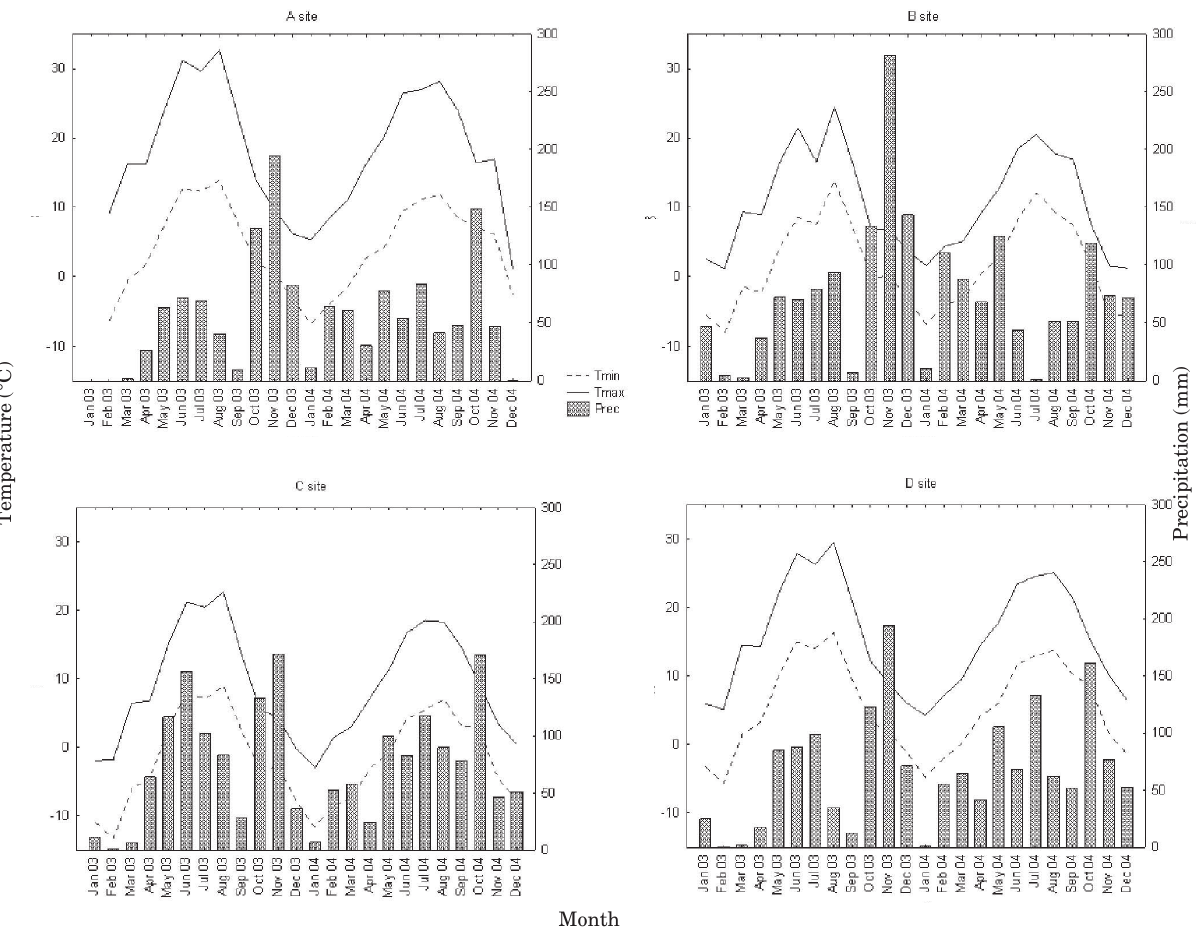
Fig. 1. Minimum and maximum temperature (Tmin, Tmax respectively) and precipitation (Prec) at the 4 sites during 2003 and